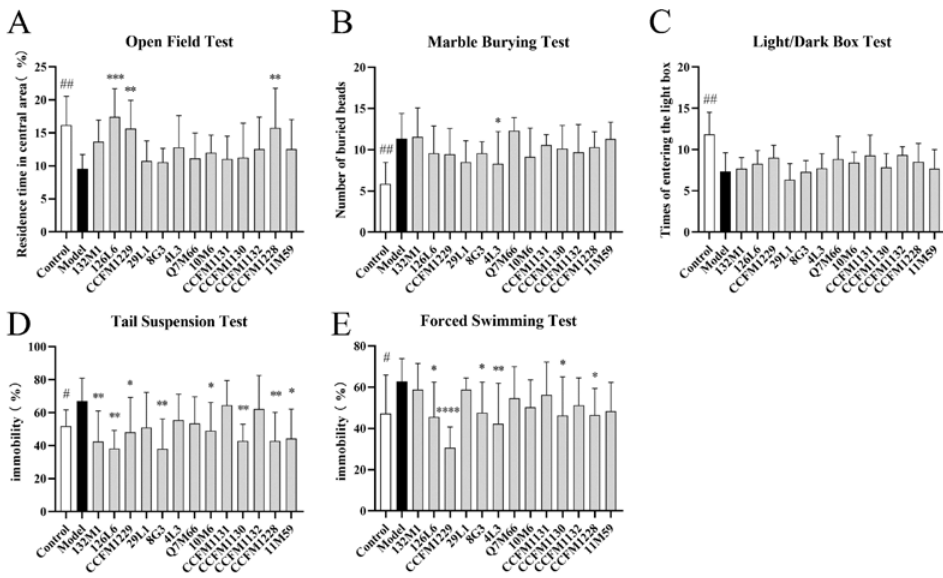
Figure 2. Behavioural tests. # p < 0.05; ## p < 0.01; * p < 0.05; ** p < 0.01; *** p < 0.001; **** p < 0.0001 comparing with depression group; n = 7–9.